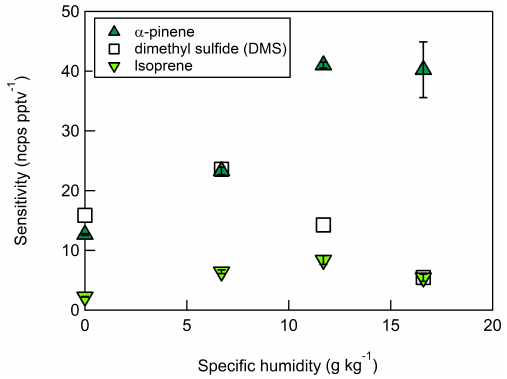
Figure 5. Humidity dependence of the laboratory-derived CI- ToFMS sensitivities to dimethyl-1,1,1-d 3 sulfide, α -pinene, and iso- prene. Error bars indicate 1 σ as determined from the slope of the calibration